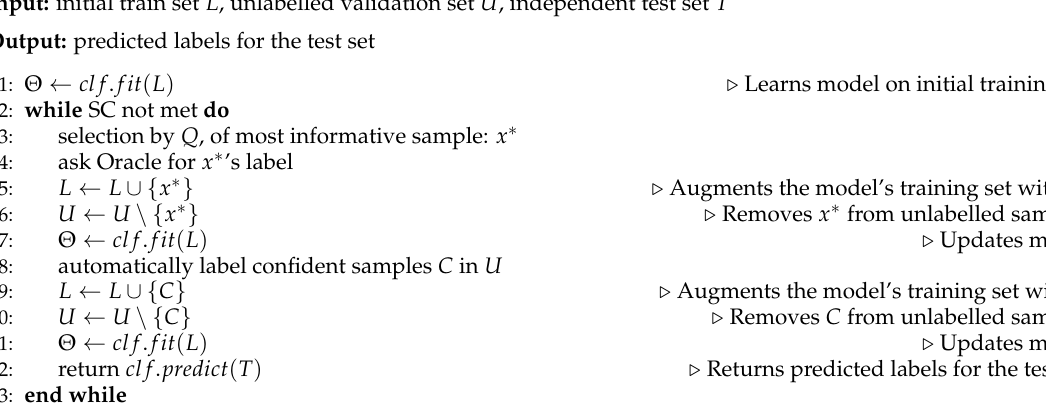
Algorithm 2 Semi-Supervised Active